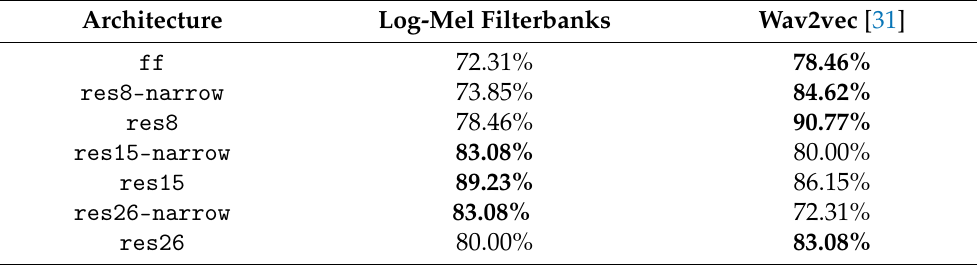
Table 3. Test accuracy for log-mel filterbanks and wav2vec feature pipelines [31]. The best result for each architecture is